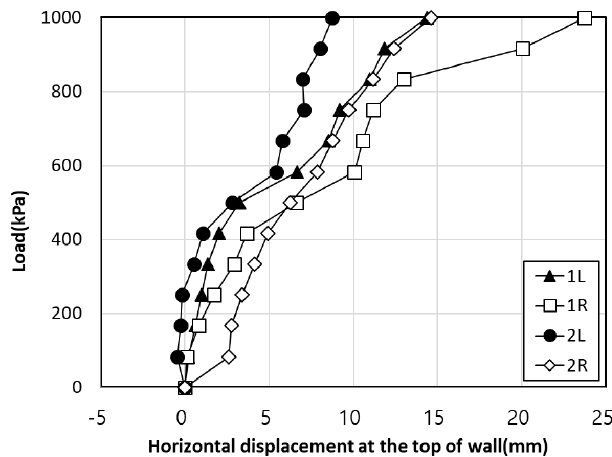
Figure 14. Load-horizontal displacement of wall curve (at the top). The wall-backfill connection method had a governing effect on the horizontal dis- placement of the wall at a low load below the yield point, which was estimated from the load-settlement curve; the length of the reinforcement had a governing effect on the load above the yield point. The smallest horizontal displacement occurred in the 2L section with reinforcement vertical spacing of 40 cm and a reinforcement length of 2 m. A similar horizontal displacement occurred in the 1L and 2R sections, which have the same rein- forcement length of 1.75 m, but different vertical spacings of 0.3 and 0.4 m, respectively, above the load of 653 kPa. Thus, the length of the reinforcement, instead of the vertical spacing, has a greater influence on the horizontal displacement of the wall.